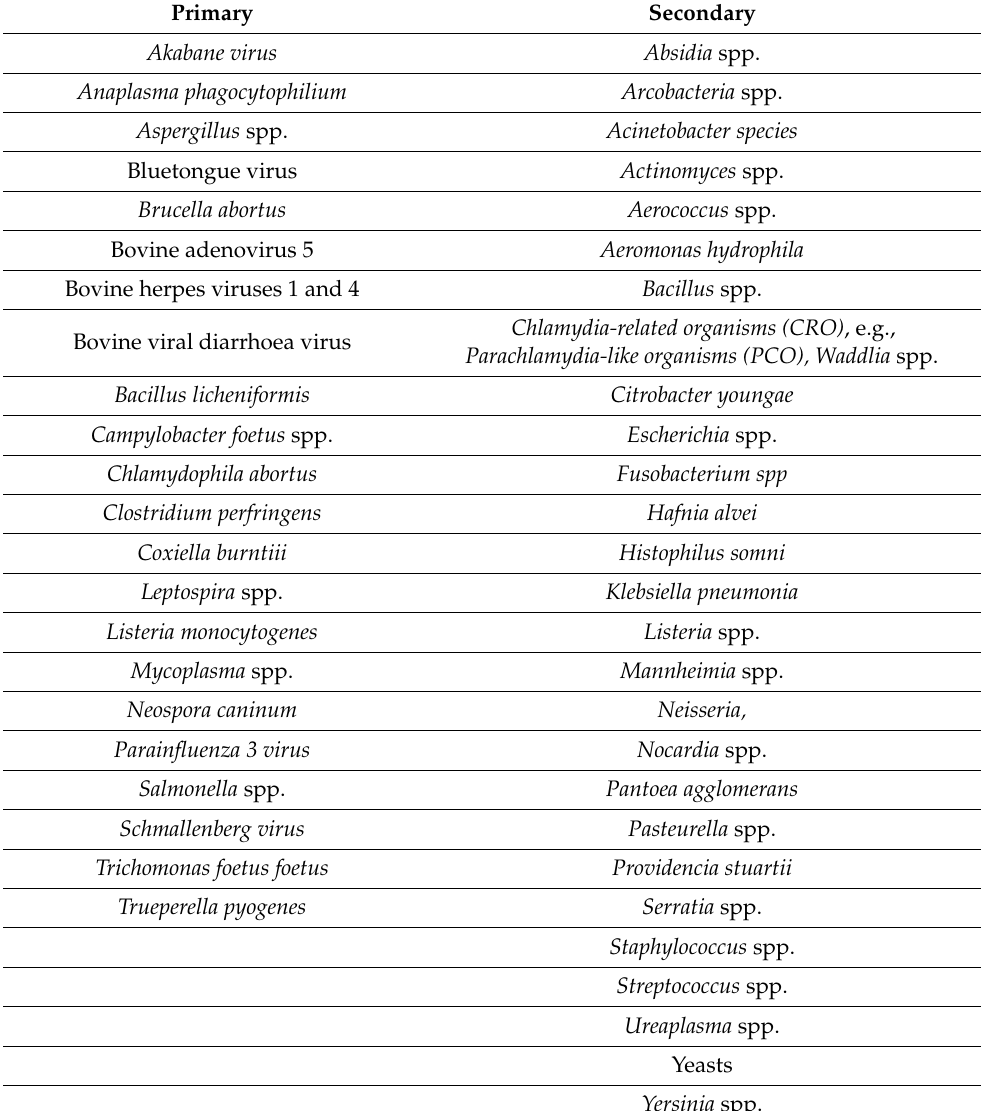
Table 2. List of primary and secondary pathogens associated with bovine foetopathy in alphabeti- cal order